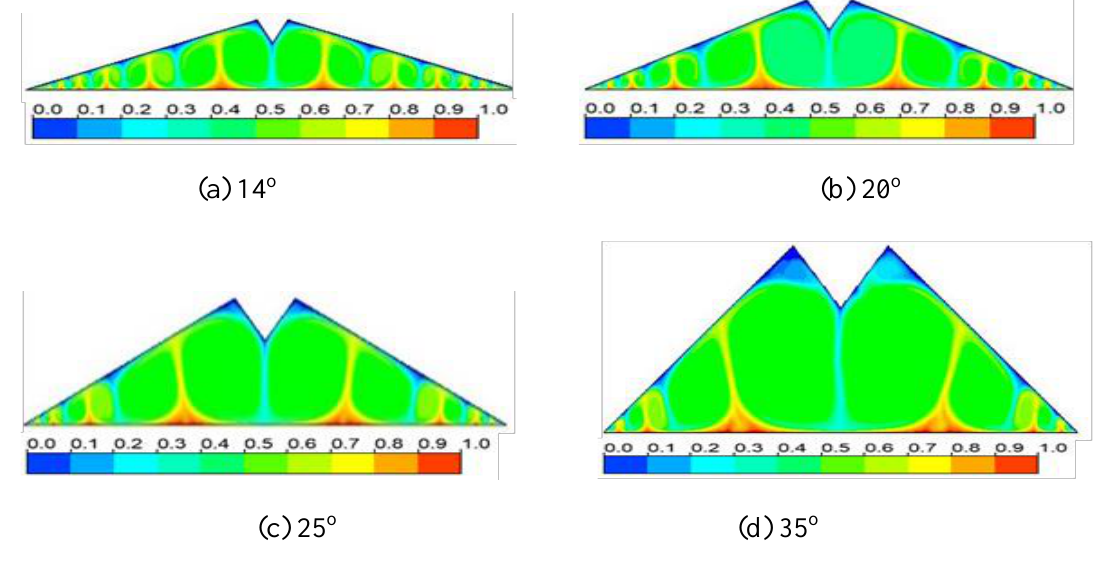
Fig. 7. Temperature contour plots.